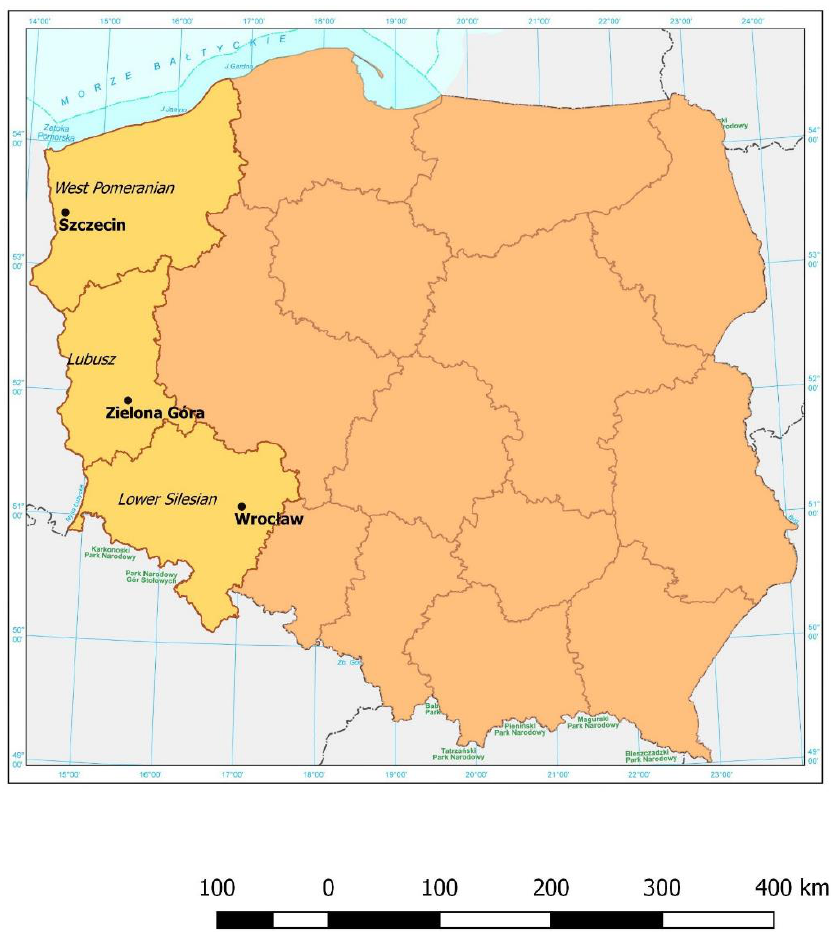
Figure 1. The location of the analyzed voivodships and meteorological stations.